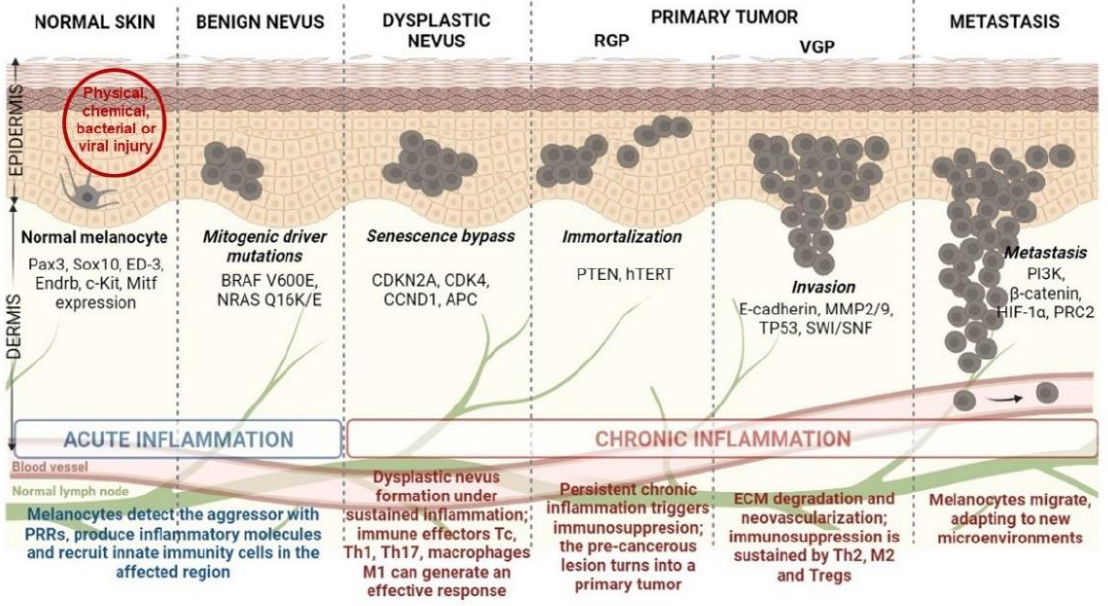
Figure 1. Schematic representation of CM development from healthy melanocyte to metastatic disease (the Clark model) under a pro-inflammatory milieu. Abbreviations: PRRs—pattern recognition receptors, Tc—cytotoxic T cells, Th1-T— helper type 1 cells, Tregs—regulatory T cells, Pax3—paired box gene 3, Sox10—SRY-box transcription factor 10, Endrb— endothelin receptor type B, c-Kit—human receptor tyrosine kinase c-kit, Mitf—microphthalmia-associated transcription factor, CDKN2A—cyclin dependent kinase inhibitor 2A, CDK4—cyclin dependent kinase 4, CCND1—cyclin D1, APC— adenomatous polyposis coli, PTEN—phosphatase and tensin homolog, hTERT—human telomerase reverse transcriptase, MMP2—matrix metalloproteinase 2, SWI/SNF—switch/sucrose non-fermentable chromatin remodeling complex, PI3K— phosphoinositide 3-kinase, HIF-1 α —hypoxia-inducible factor-1 α , PRC2—polycomb repressive complex 2.